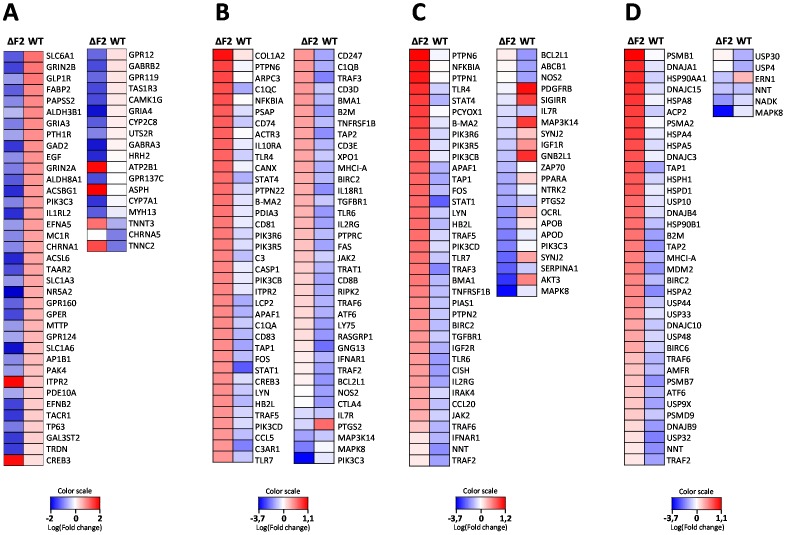
Heat maps of selected genes in the lungs of ΔF2- and wt-infected chickens at day 2 pi.Genes shown in red are upregulated and genes in blue are downregulated. Data are expressed in Log base 2 ratio. (A) Heat map of genes related to “Calcium Signaling pathway”. (B) Heat map of genes related to “Hematological System Development and Function”. (C) Heat map of genes related to “Cell to Cell Signaling and Interaction”. (D) Heat map of genes related to “Cellular Compromise”.